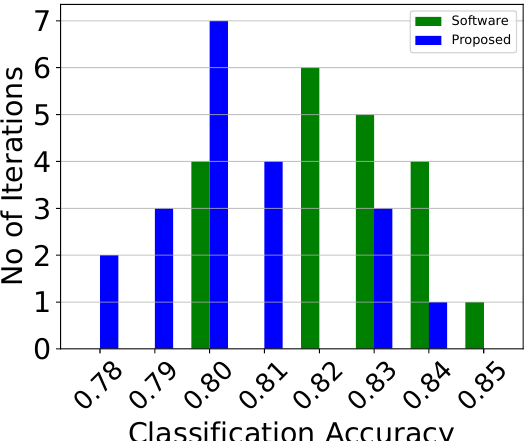
Figure 14. Classification accuracy histogram of the analog centroid-based classifier attached to the third electrode (classifier 3) over 20 iterations.